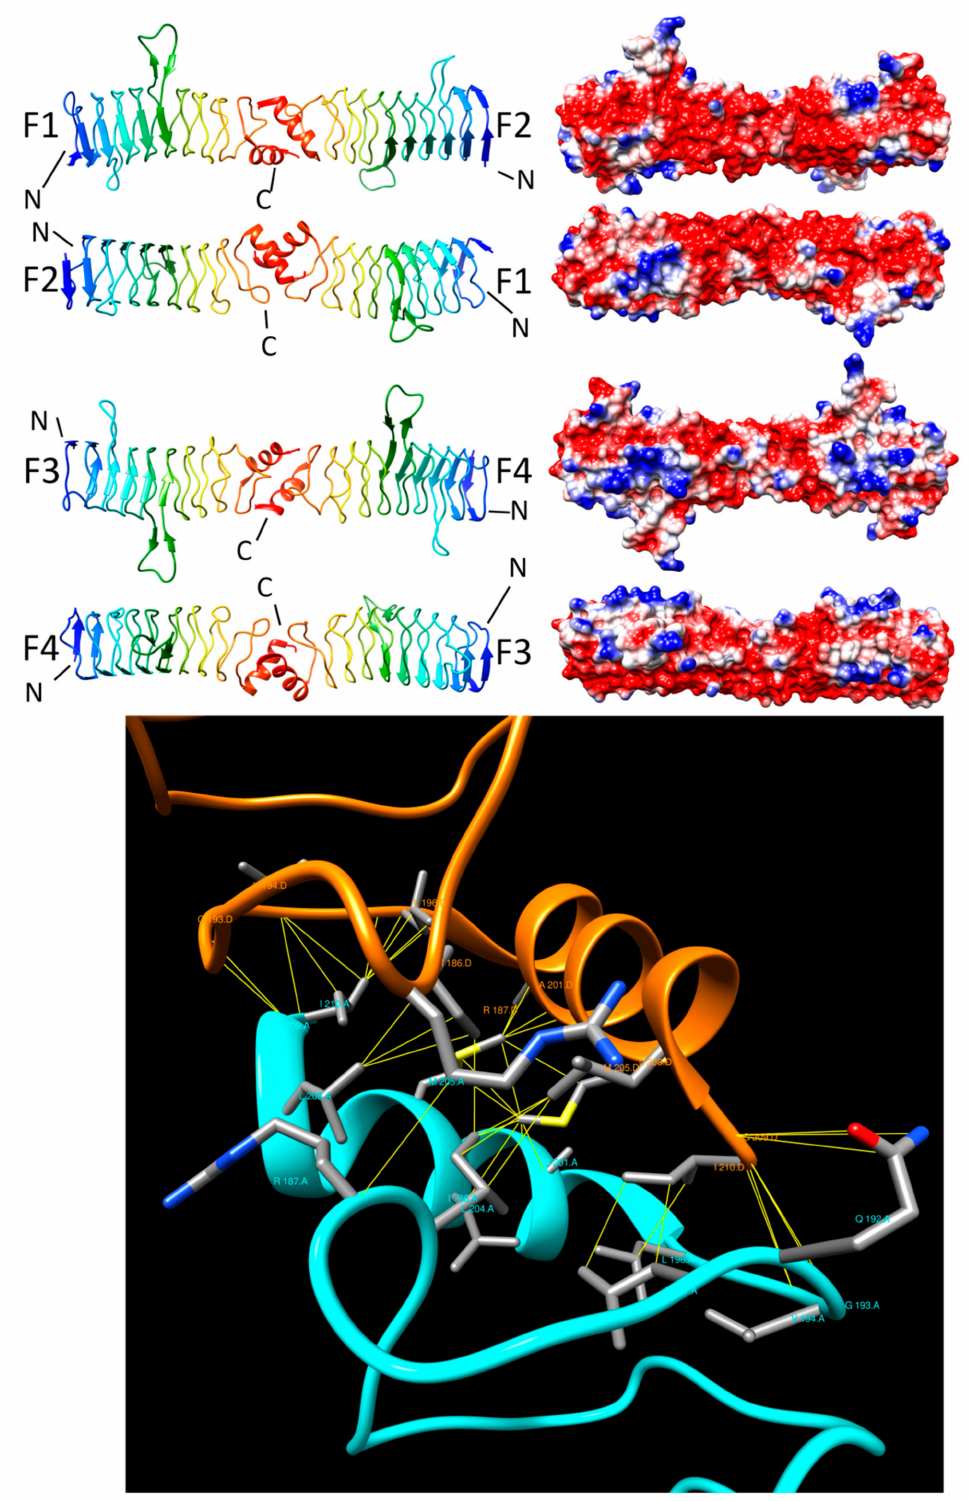
Figure 6. Structure and analysis of QnrB1. The top panel shows the ribbon diagrams of the structure for four different orientations (at left) and the corresponding electronic potential surface plots (at right). The bottom panel is the interface model calculated by Intersurf and depicted using Chimera. In 2019, Li et al. showed that QnrB increased bacterial mutation rates and the selection of quinolone-resistant mutants [33]. Transcriptomic and whole genome sequencing